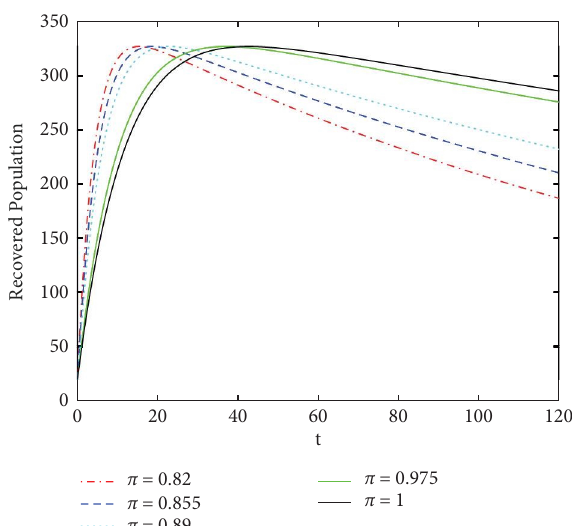
Figure 15: Te dynamics of exposed human population for various fractal orders π and for fractional order υ � 0 .